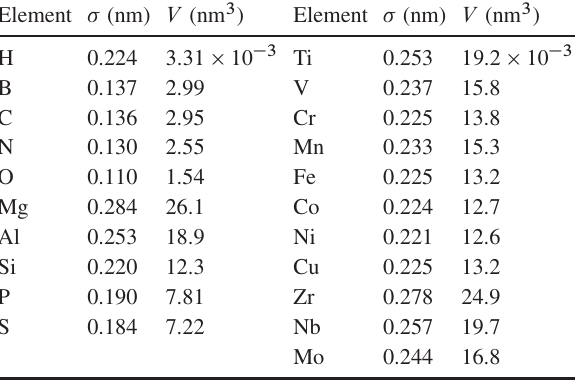
Table 1. Hard sphere diameter and atomic volume of ele- ments estimated from measured structure factor and den- sity data near the melting point. The atomic volume of non-metallic elements was estimated from the relation